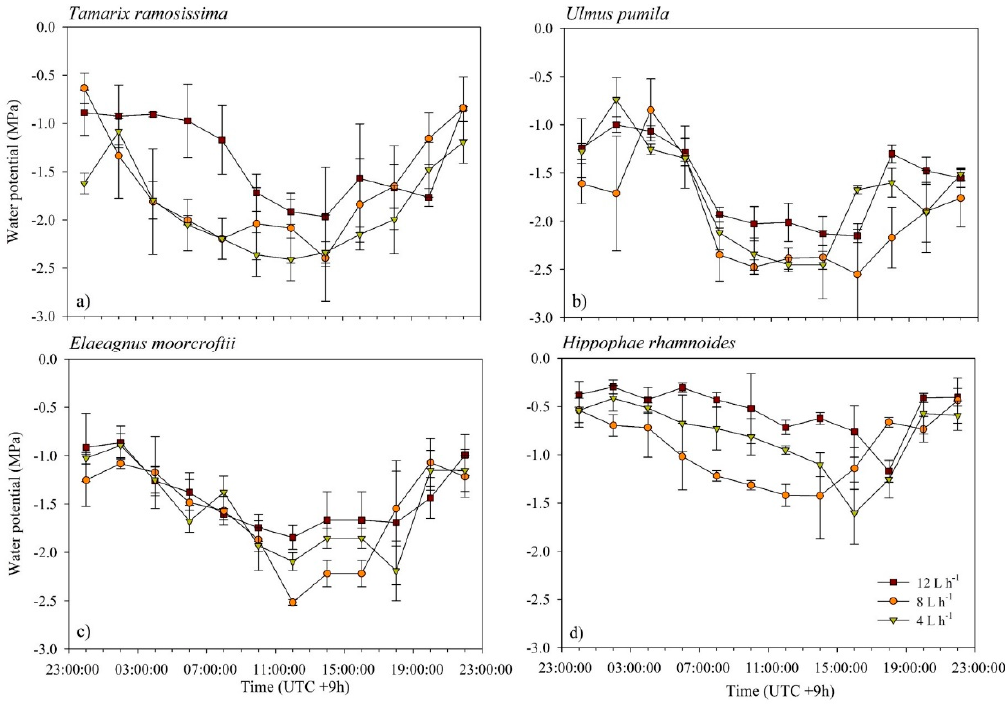
Figure 7. Diurnal variation in leaf water potential ( Ψ ) of ( a ) Tamarix ramosissima , ( b ) Ulmus pumila , ( c ) Elaeagnus moorcroftii , and ( d ) Hippophae rhamnoides across different irrigation treatments (12, 8, and 4 L h − 1 ) measured in July 2016. Vertical bars represent standard errors.